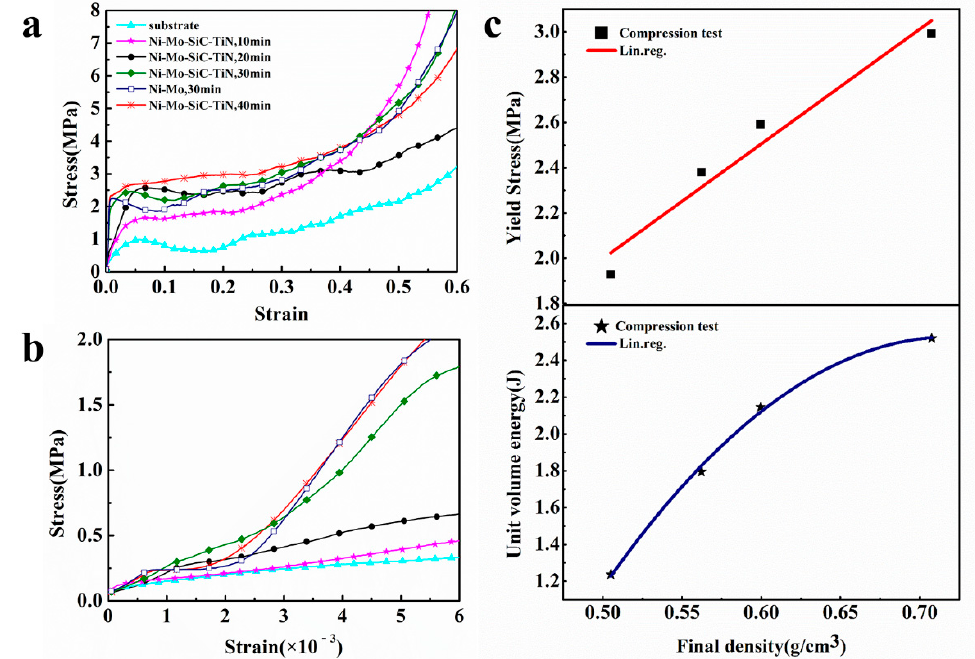
Figure 6. ( a ) Stress–strain curves of aluminum foam and aluminum foam subject to electrodeposition at the voltage of 6.0 V; ( b ) the enlarged elastic region of ( a ). ( c ) the yield strength and unit volume energy in function of the final density of samples.